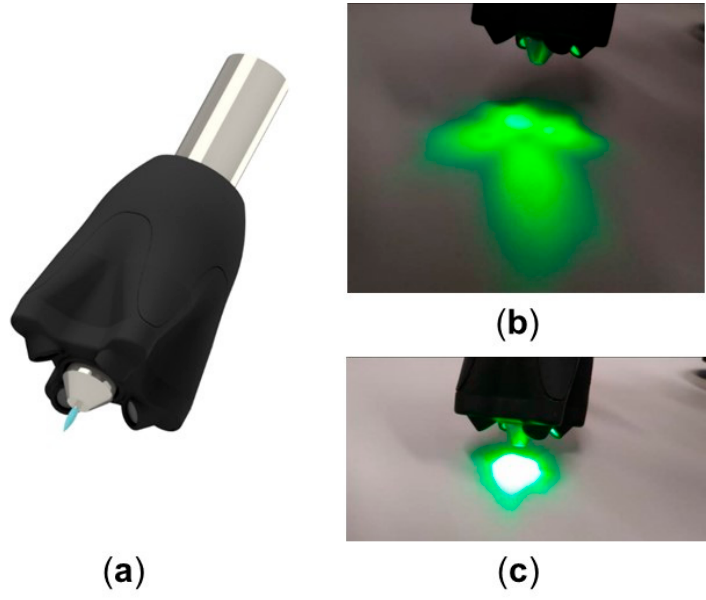
Figure 14. ( a ) Computer-aided design image of the simplified visualization tool, ( b ) picture of the four LED spots diverging due to high distance and tilting, ( c ) picture of the four LED spots converging at treatment distance.